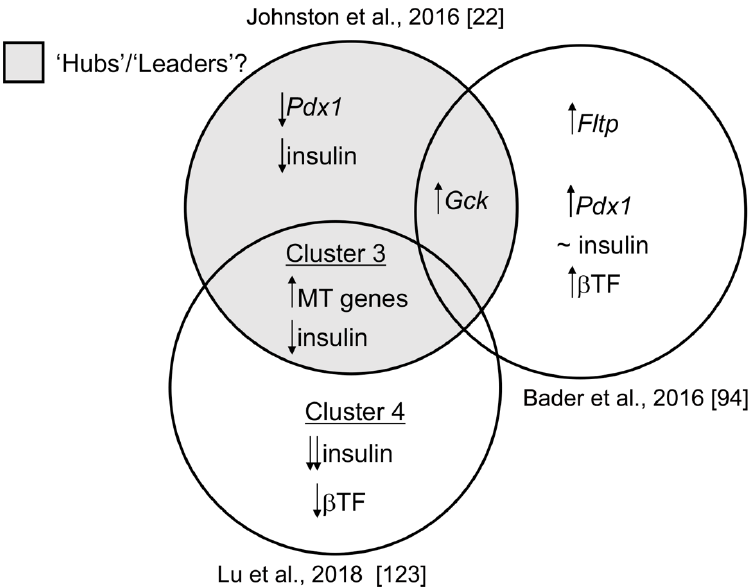
Figure 2. Evaluating the overlap of defined transcriptomic heterogeneity between beta cell subpopulations in mice. “Hub” cells [22] exhibit lower Pdx1 , Ins1 and higher Gck expression levels, as assessed by immunocytochemistry, indicative of a less mature but highly metabolic cell state. According to Bader et al. [94], FACS-sorting of islet beta cells into Fltp -positive and Fltp -negative populations revealed that the former was marked by expression of Pdx1 and several key beta cell transcription factors ( β TF) and, similar to “hub” cells, by increased expression of Gck . Expression of insulin was similar between Fltp -positive and Fltp -negative beta cells. scRNA-sequencing of primary mouse beta cells by Lu et al. [123] revealed a population of beta cells (termed “cluster 3”) with increased mitochondrial (MT) gene expression and reduced expression of insulin, but with comparable levels of beta cell transcription factors ( β TF) as mature beta cells (termed “clusters 1 and 2”), consistent with “hub” cells. “Cluster 4”, in this analysis, represents immature beta cells with significantly reduced insulin levels and key beta cell transcription factors ( β TF). Whether the expression of imprinted genes is enriched in any of the above subpopulations remains to be determined. Black arrows represent up- or down regulation of gene